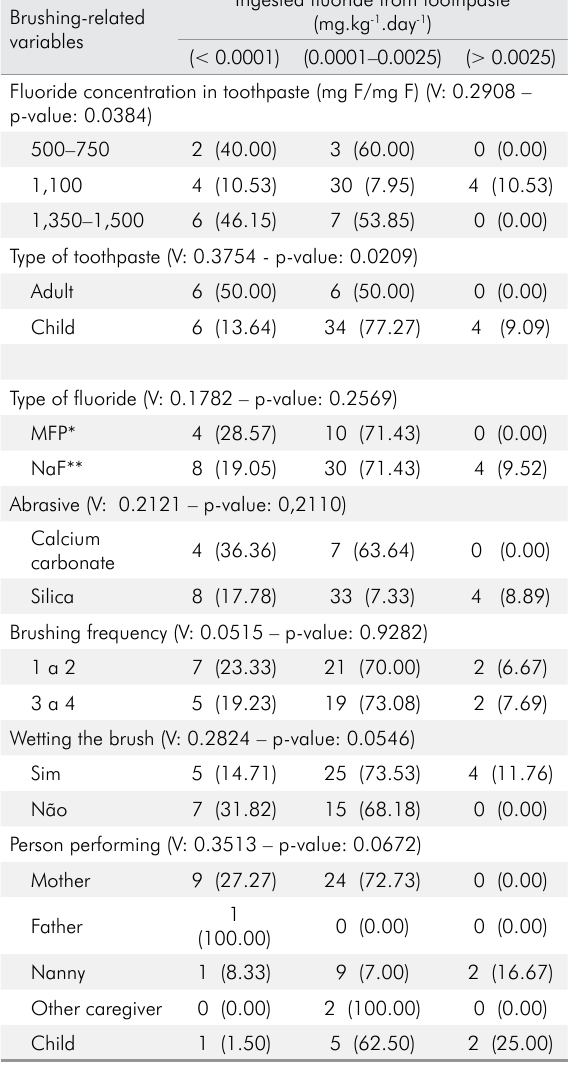
Table 4. Frequency (percentage), statistical V Cramer and p-value of the chi-square likelihood ratio (G2) to assess the associations between the amount of ingested fluoride and the variables related to brushing. Brushing-related